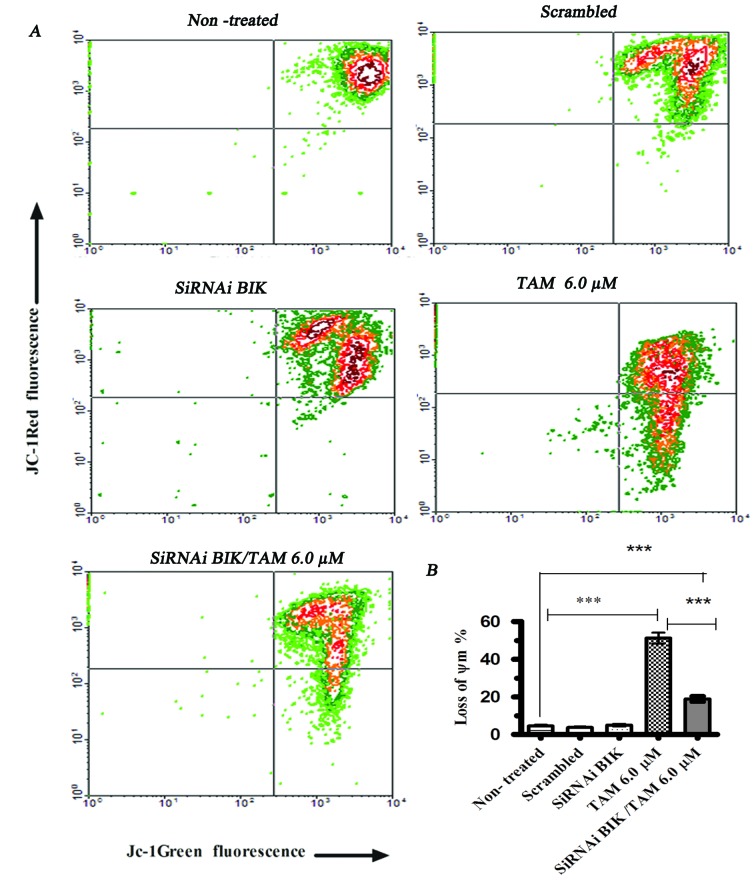
Suppression of Bik expression does not alter the mitochondrial membrane potential. (A) MCF-7 cells [non-treated, scrambled, siRNAiBIK, siRNAiBIK/tamoxifen (TAM), and TAM] were stained with JC-1 for loss of ΔΨm using flow cytometry. JC-1 fluorescence is seen in both the FL-2 (red) and FL-1 channels (green). In FL-1 channels are cells with low levels of ΔΨm, while Fl-2 channel indicates cells with stable levels of ΔΨm. (B) Representative graphic of fluorescence intensities. One representative of at least three independent experiments with similar results is shown. The groups were analyzed by one-way analysis of variance (ANOVA) with the Tukey’s test. *p<0.05; **p<0.01; ***p<0.001 vs. non-treated. Representative figures of three independent experiments carried out in triplicate are shown.